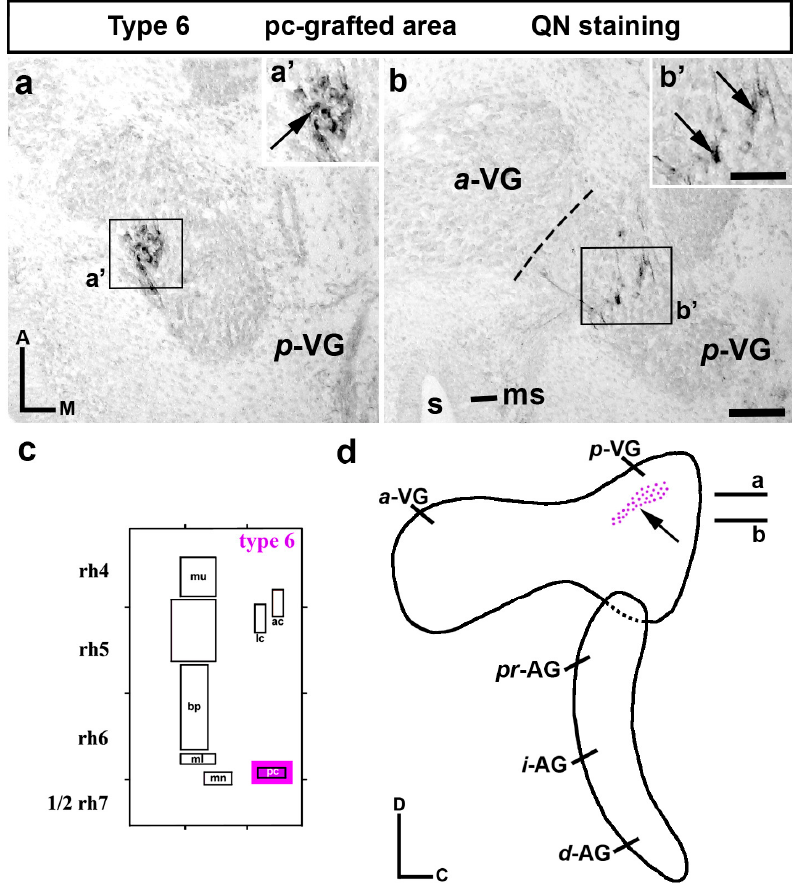
Figure 6. Graft-derived quail ganglionic neurons from the extended area of the posterior crista (type-6 grafts; n = 6). ( a,b ) Horizontal sections through the VG. The dotted lines in b define the separation between the anterior and posterior lobes of the VG ( a -VG and p -VG). A few QN-stained grafted quail neurons were detected exclusively in the p -VG (arrows in ( a’ , b’ )). The a -VG ( b ) and the AG were devoid of pc-grafted neurons. ( c ) Schematic representation of the type-6 grafts performed at the 10-somite stage, considering the expanded sensory area of the posterior crista (pc; purple areas). ( d ) Diagram summarizing the results, the arrow points to the restricted location of grafted neurons in the VG. Orientation: A, anterior; C, caudal; D, dorsal; M, Medial. Additional abbreviations: ms, macula sacculi; s, saccule. Scale bar = 19 µm in ( a , b ); 9.5 µm in ( a’ , b’ ).